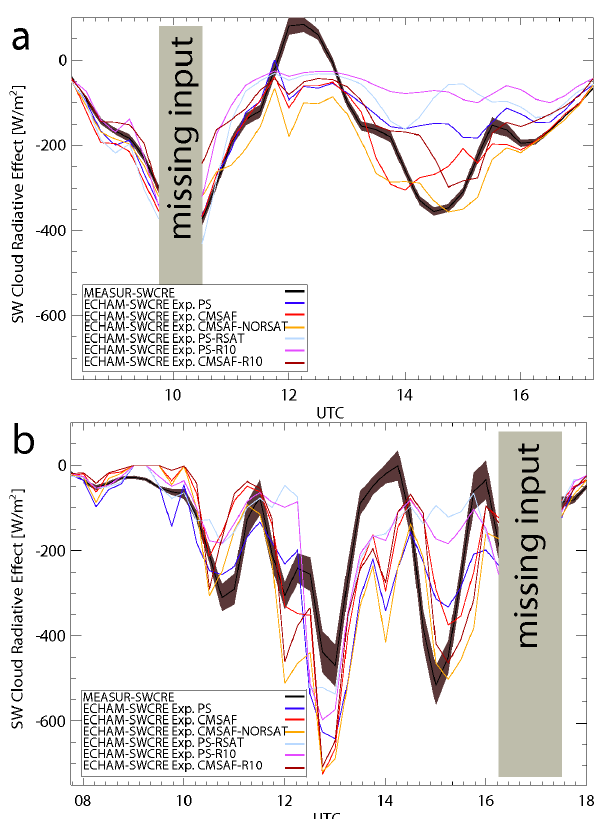
Fig. 3. SWCRE for 3 November 2007 which was dominated by op- tical thin overcast conditions (a) and the SWCRE for 10 November 2007 which was dominated by broken cloud conditions with a large averaged cloud fraction (b) . The grey area around the observation line refers to the standard deviation within the 30min averaging pe-